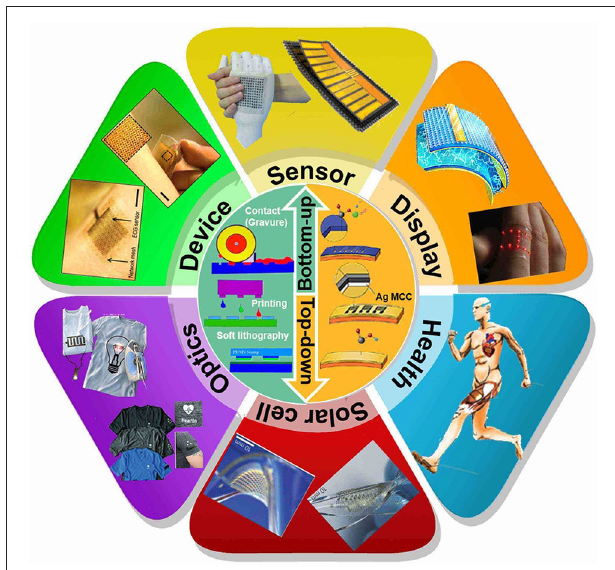
FIGURE 1 | Two strategies for fabricating flexible electrodes and the products that use electrodes. These technologies include both top-down and bottom-up methods. The top-down method involves electrode materials being deposited on the substrate by various physical methods. The bottom-up method involves an ion-exchange between the electrode materials and the electrode ions which grow from the bottom. The technology of flexible electrode fabrications can be applied to different devices (Jang et al., 2015). Reproduced with the permission of 2015 Macmillan Publishers Limited. These devices include flexible sensors (Jang et al., 2014; Zhang et al., 2015), flexible display screens ( Gao et al., 2016; Leung et al., 2018), human health detection devices ( Wang X. et al., 2017), solar cells (Son et al., 2014), and optical clothes ( Lee et al., 2018). Reproduced with the permission of 2015